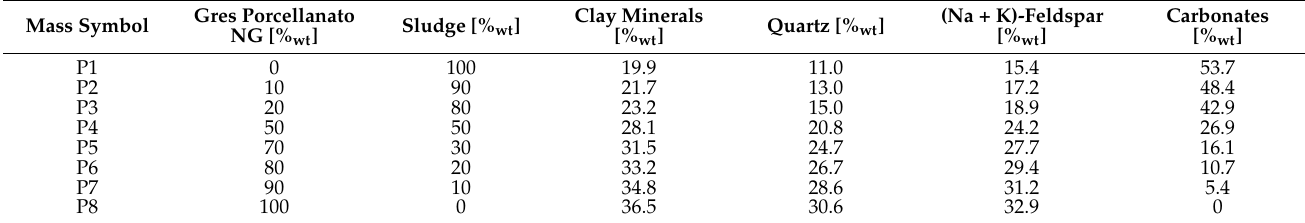
Table 2. Rational composition of sets.